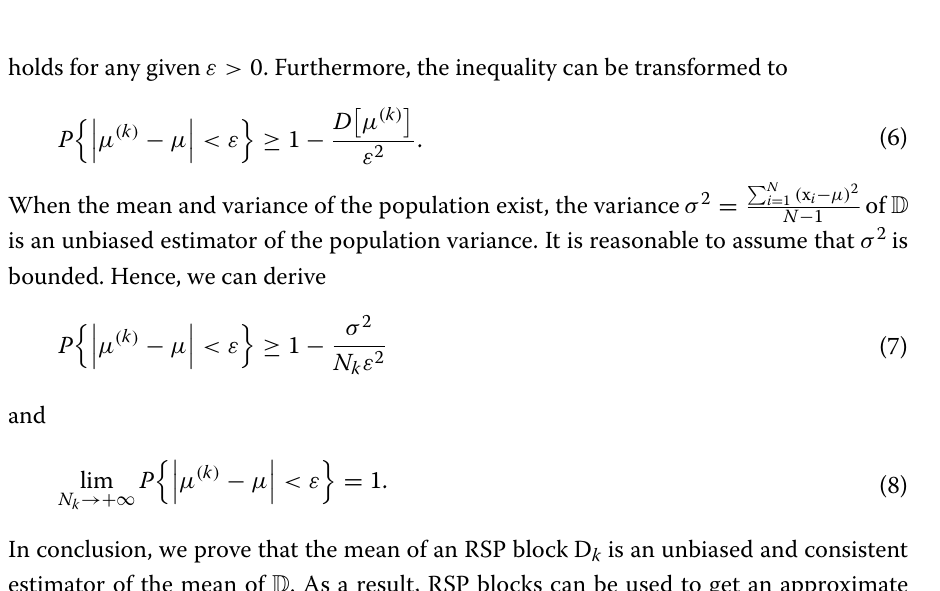
Characteristics of the real data sets and the RSPs generated for them